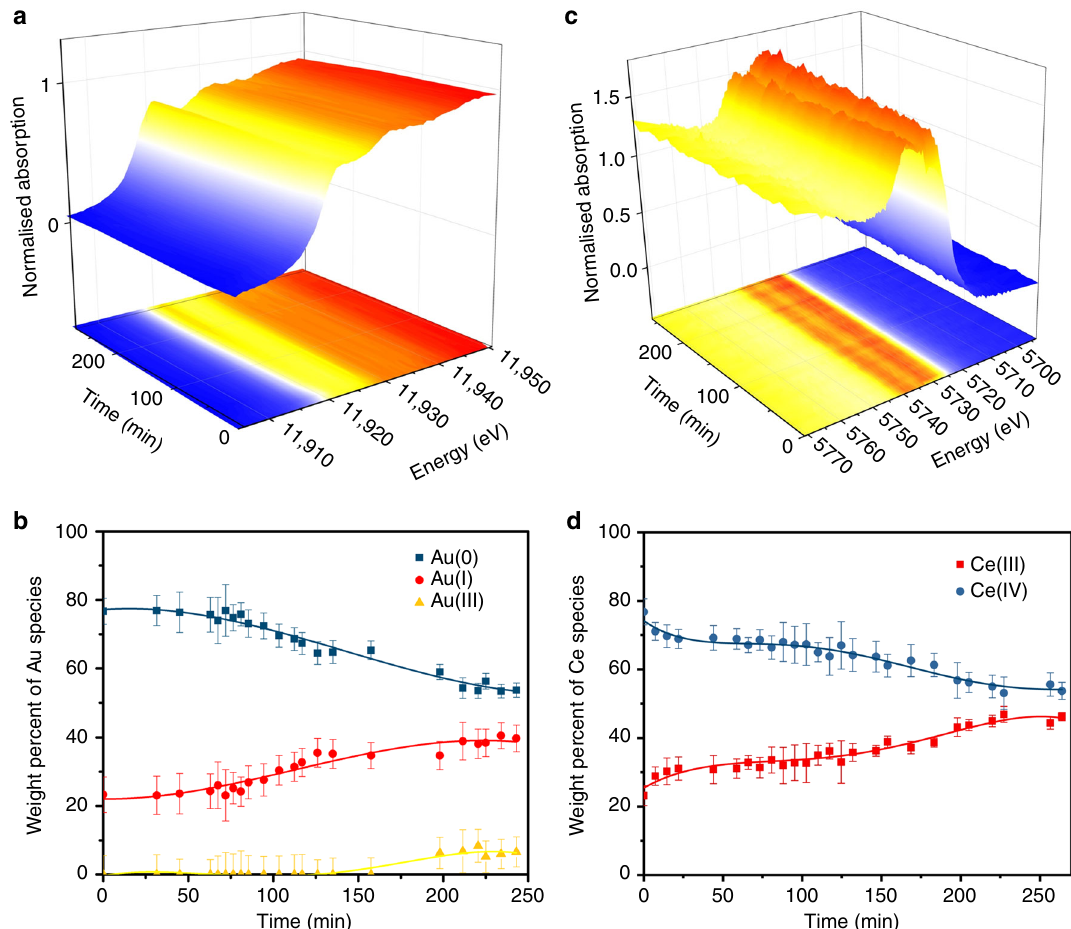
Fig. 3 In-situ XANES of 1.0 wt% Au/CeO 2 &AC catalyst and relative fi tting values. a The in situ XANES spectra of Au L 3 edges as a function of reaction time and b the relative linear combination fi tting analysis with the fi tting errors. c The in situ XANES spectra of Ce L 3 edges as a function of reaction time and d the relative multiple peak fi tting analysis with the fi tting errors. To minimise the conceivable in fl uence by acetylene adsorption and the changes in metal speciation geometry in XANES spectra fi tting, the higher ratio of HCl/C 2 H 2 = 2: 1 (Fig. 1e). Au standards of 1.1 Au(III) (e.g. [AuCl 4 ] − ), 0.7 and 1.0 Au (I) (e.g. [AuCl 2 ] − and AuCl), and Au(0) foil, Ce standards of 1.8 Ce(IV) and 2.6 Ce(III) are used for fi tting the typical normalized white-line intensity values (Supplementary Figure 6). The details of the fi tting are described in supporting information. Before introducing the reactants into micro-reactor, the fresh Au/CeO 2 &AC catalyst was heated to 180 °C in N 2 gas for 30 min. The colour indicates the difference in the white-line intensity: from 0 to 0.5 to >1 (blue to yellow to red) for Au, 0 to 0.8 to >1.5 (blue to yellow to red) for Supplementary Figure 10. So, we calculated the subsequent dis- sociation of three HCl molecules on the same stabilized Au atom by CeO 2 . First, a CeO 2 model (10.822 × 7.652 × 21.652 Å) with exposed (110) plane was constructed. When a free Au atom was placed over the CeO 2 (110) plane, it converged to give a strong adsorption energy of − 2.1 eV with the Au atom located at the top-middle of four oxygens of the CeO 2 (110) plane, as shown in Fig. 4c. The subsequent energy pro fi les for HCl dissociations and the geometries of the complexes are shown in Fig. 4b. As observed in the initial state (I.S.), the hydrogen chloride is adsorbed on Au through its Cl atom. At the transition state (T.S.), the H atom of HCl leaves the Cl (distance) and moves to the O atom of CeO 2 , as described in Fig. 4b. The highest energy barrier between T.S. and I.S. is 1.87 eV, which is the fi rst activation barrier of the dissociation of the HCl. Consequently, the dis- sociation energies for the second (2.20 eV) and third (2.45 eV)